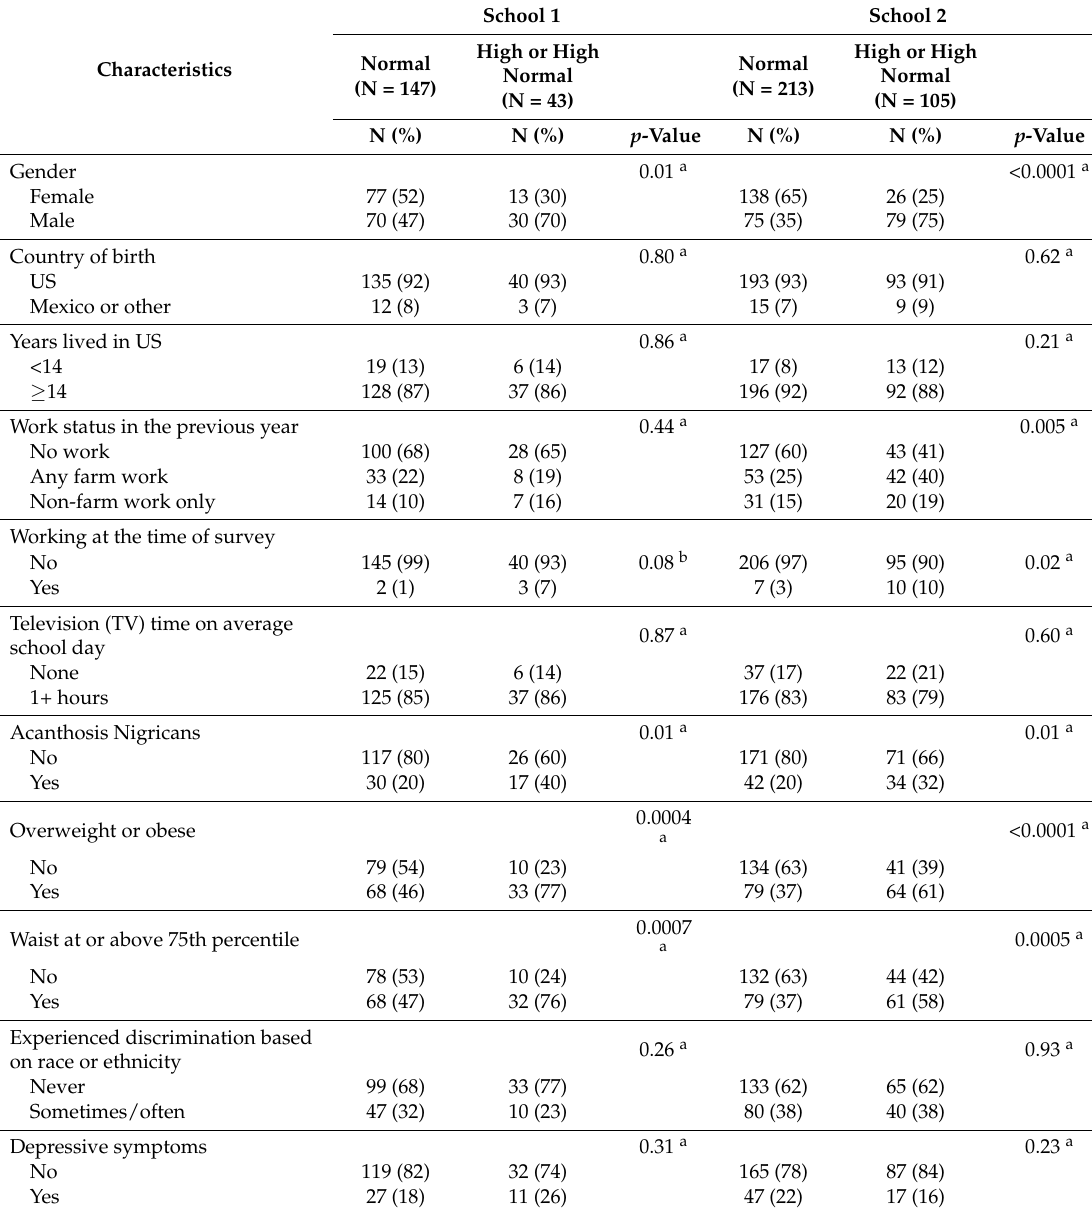
Table 2. Baseline characteristics of participants by blood pressure